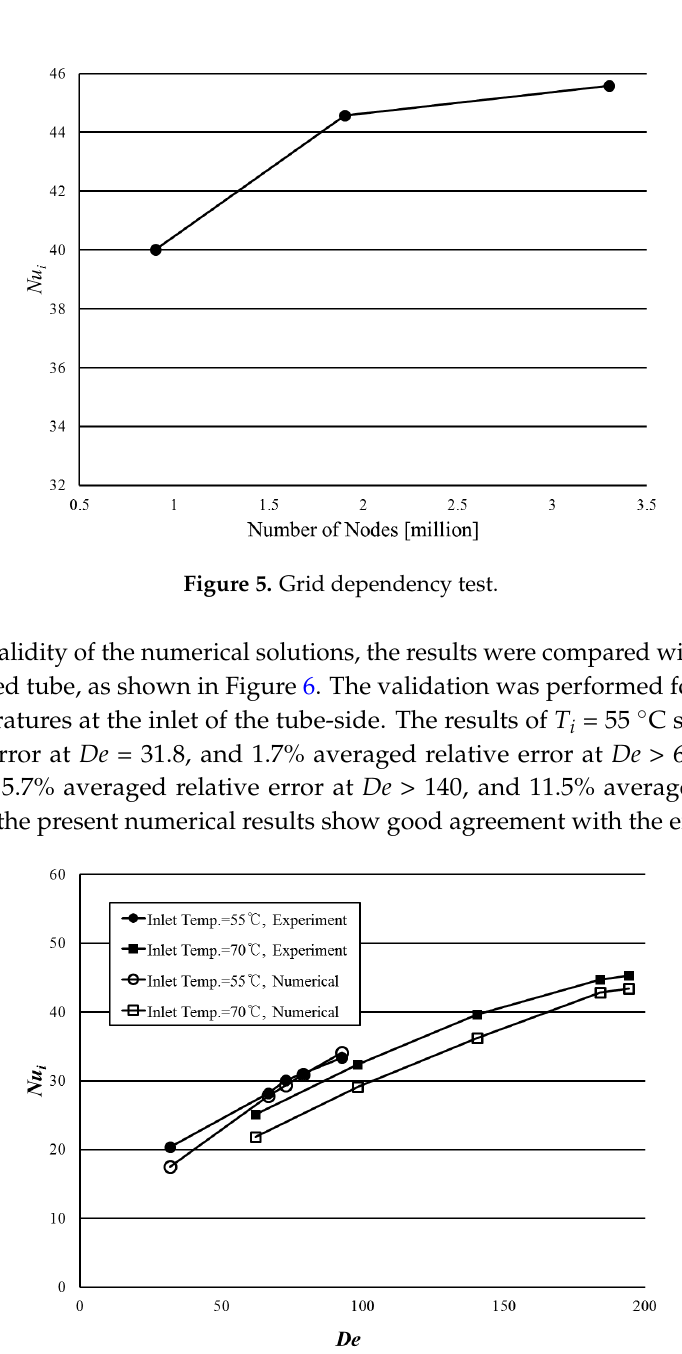
Figure 6. Validation of the numerical results with the experimental data [20] for the Nusselt number inside the helically-coiled tube.